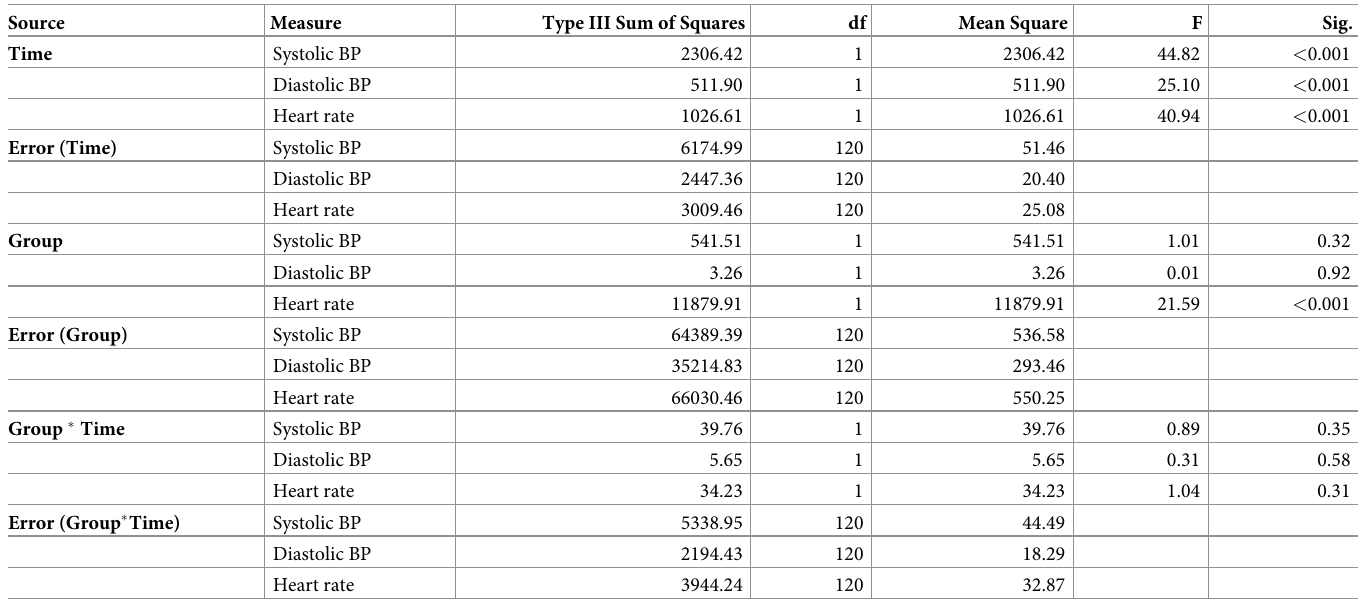
Table 4. Differences in BP and heart rate of the participants in the different waiting area settings (ANOVA with repeated measures, significance p < 0.05). Source